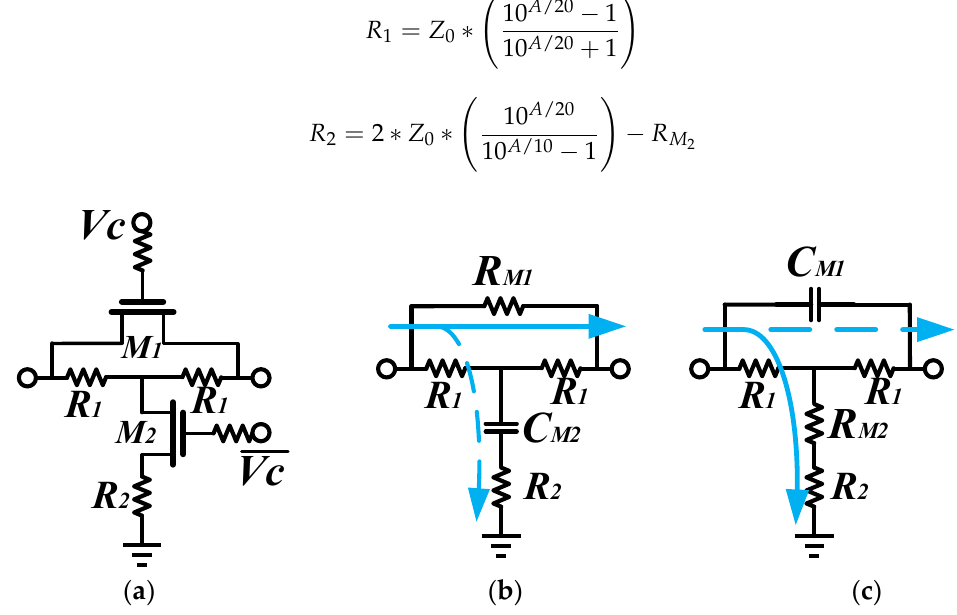
Figure 2. ( a ) The schematic of the conventional switched T-type attenuation cell. ( b ) Reference state. ( c ) Attenuation state.